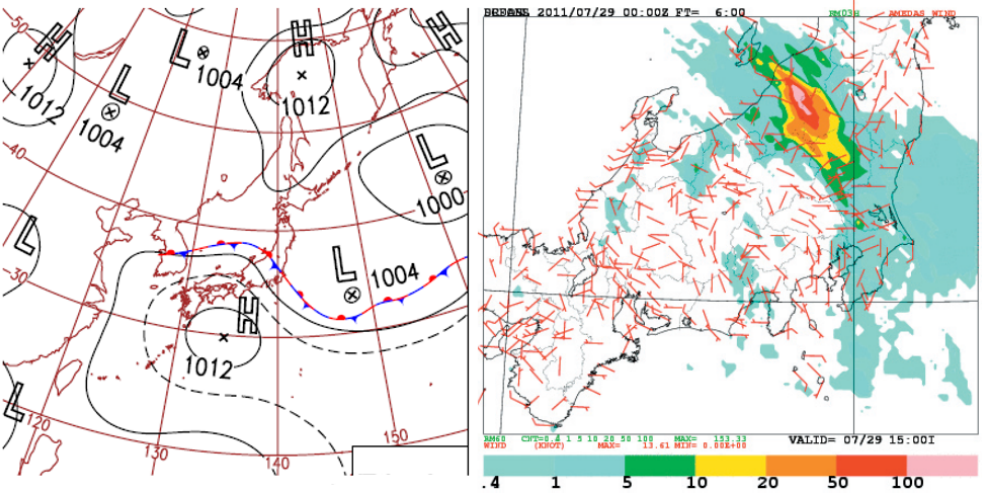
Figure 1. Surface weather map for 09:00JST, 29 July (left). Three-hour accumulated observed rainfall from 12:00 to 15:00JST